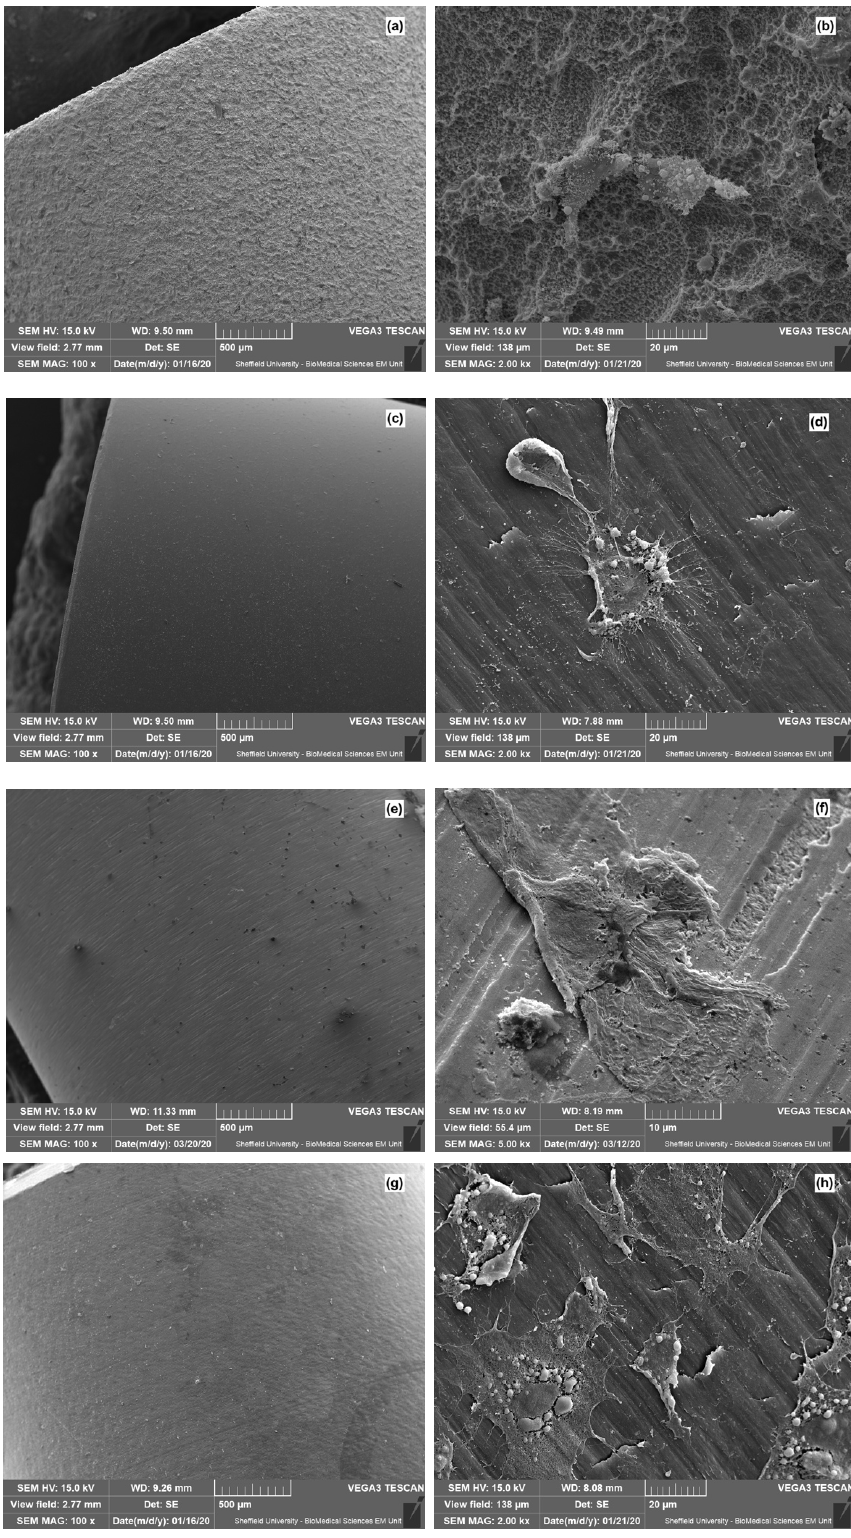
Figure 5. The scanning electron microscopy (SEM) micrographs of the ( a ) TiZr-SLA surface, ( b ) TiZr-SLA surface with cell attachment, ( c ) TiZr-M surface, ( d ) TiZr-M surface with cell attachment, ( e ) ZrO 2 -M surface, ( f ) ZrO 2 -M surface with cell attachment, ( g ) machined PEEK surface, and ( h ) machined PEEK surface with cell attachment.